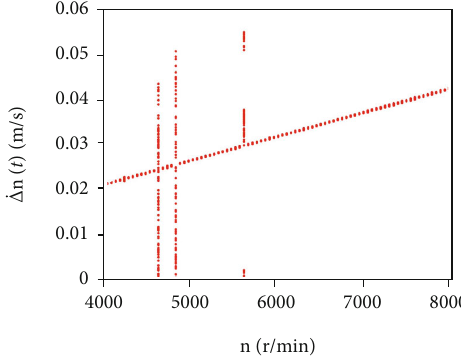
Figure 25: Bifurcation diagrams with changes in the rotation